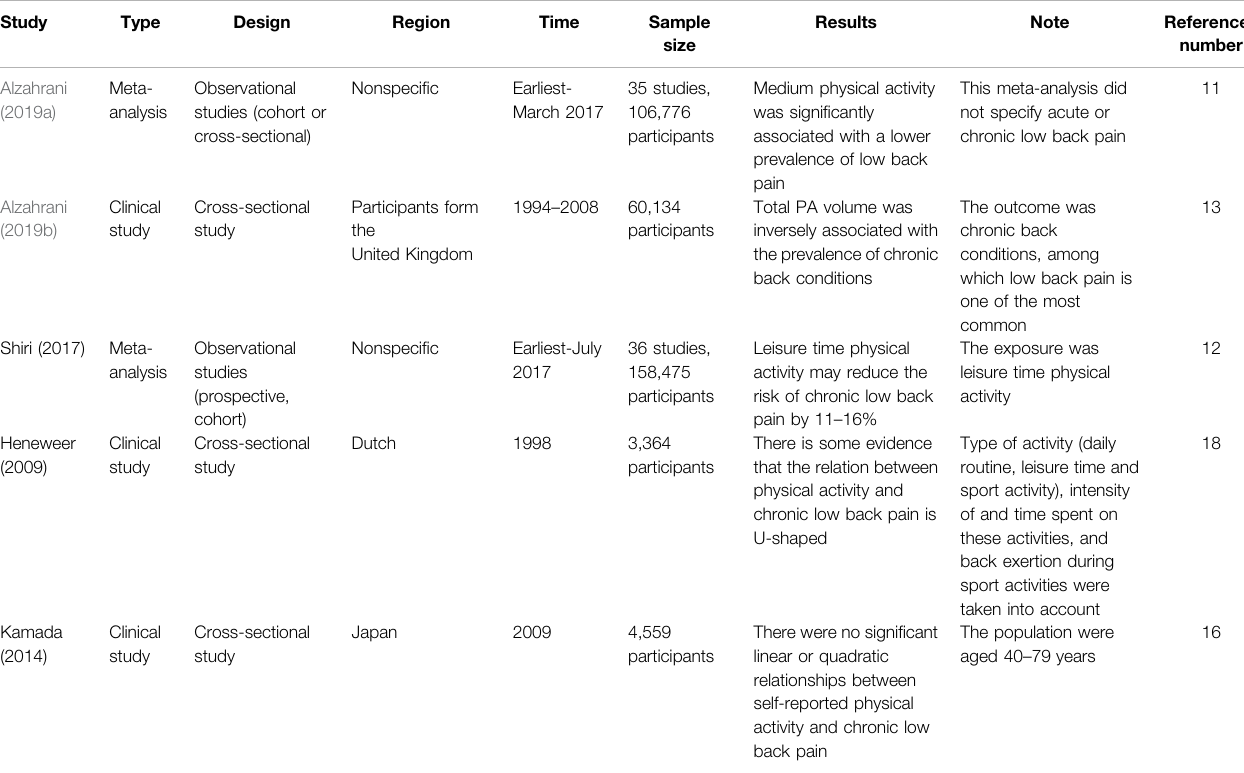
TABLE 1 | Representative studies for the association between physical activity and chronic back